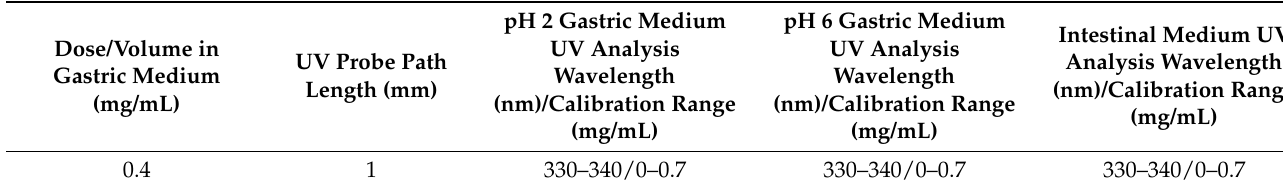
Table A6. UV analysis wavelengths and calibration ranges for gastric to intestinal transfer dissolution test using a USP 2 transfer